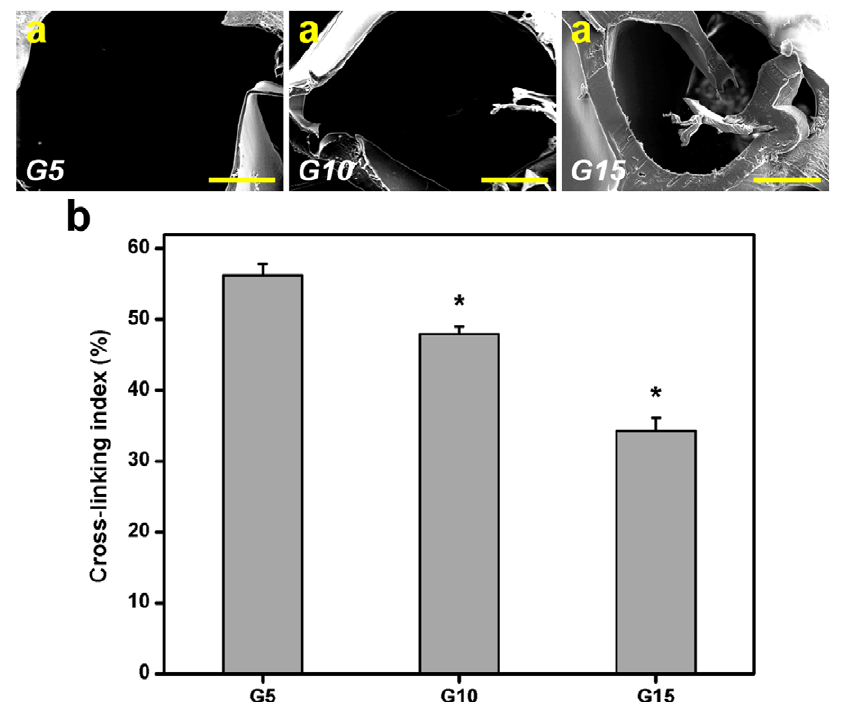
Figure 2. Morphological observations and cross-linking analyses. (a) Representative scanning electron microscopic images of various gelatin discs after cross-linking. Scale bars: 100 m m. (b) Cross-linking index of various gelatin discs. An asterisk indicates statistically significant differences (* P , 0.05; n =5) as compared with the G5 groups.